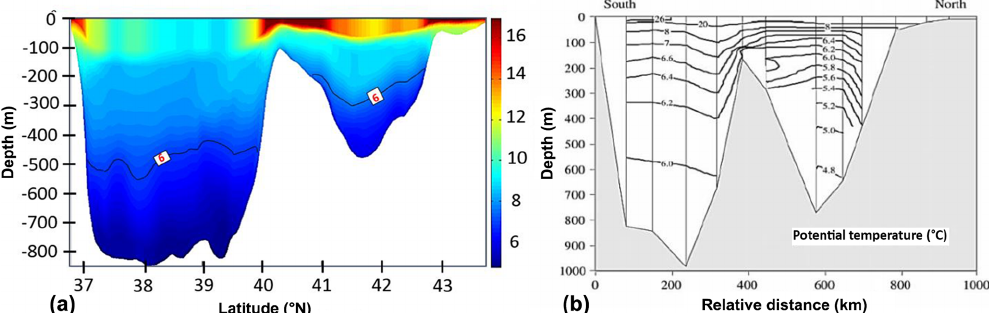
Figure 7. Comparison of the north–south cross sections of mean temperature obtained from model simulation (a) and Peeters et al. (2000) measurements (b) during September. The 6 ◦ C isotherm is marked for easier comparison.